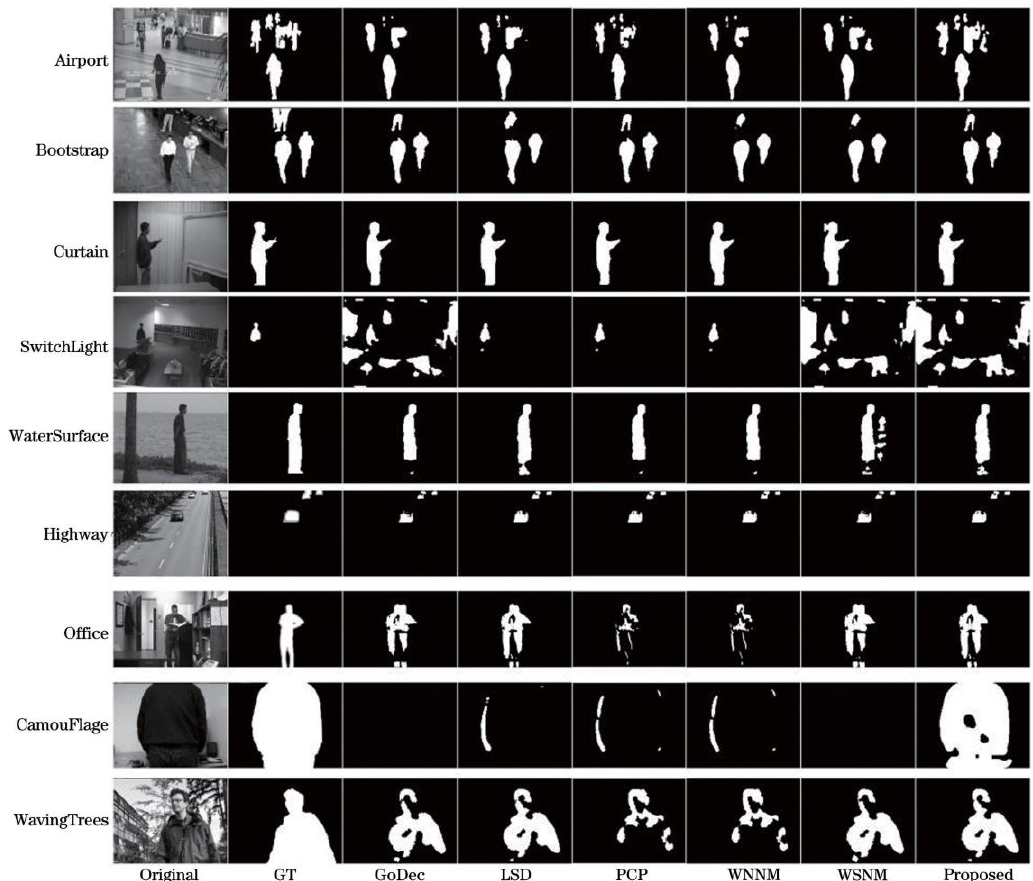
Figure 8. Results of six algorithms on nine